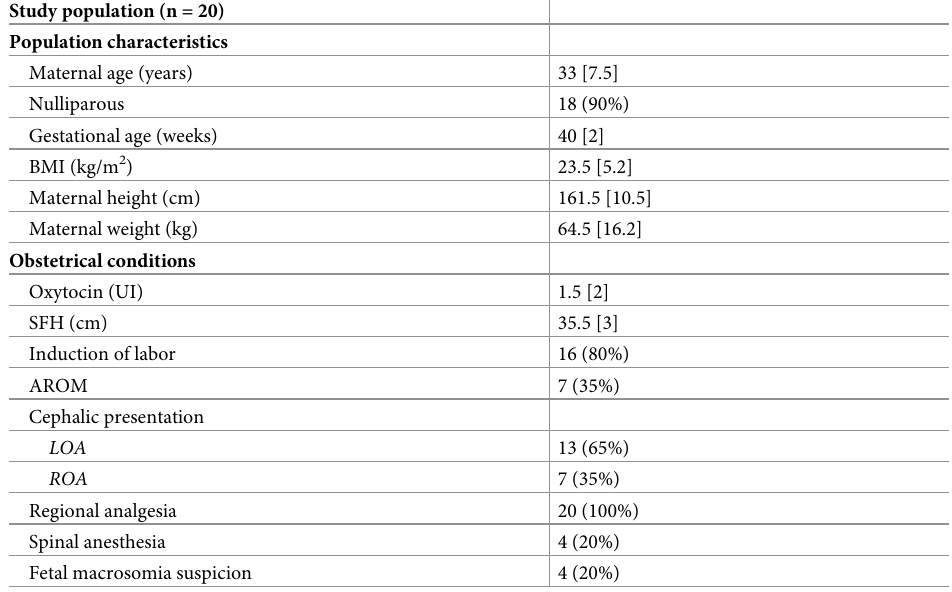
Table 1. Demographic and obstetrical characteristics just before adopting the biomechanically-optimized